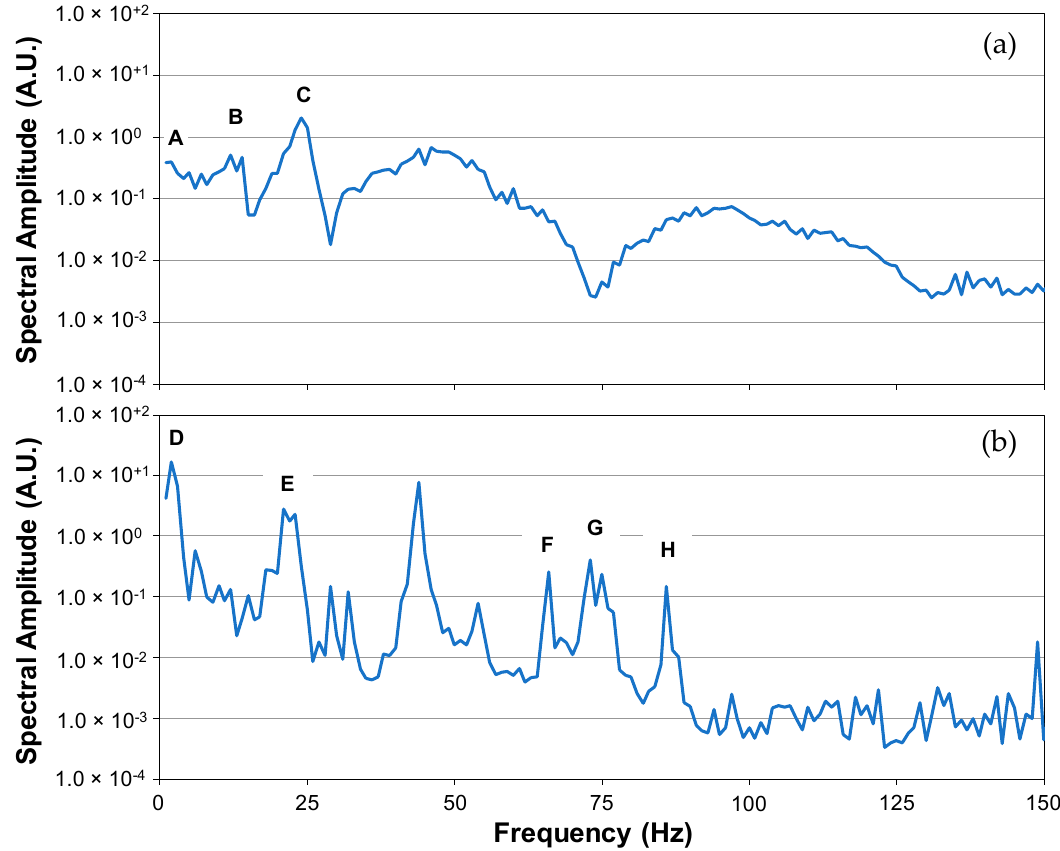
Figure 3. Mobility plots (based on shear force) corresponding to our APD-800 polisher (Araca, Inc., Tucson, AZ, USA) during seven periodic hammer strikes ( a ) and during a typical copper chemical mechanical planarization (CMP) process ( b ).